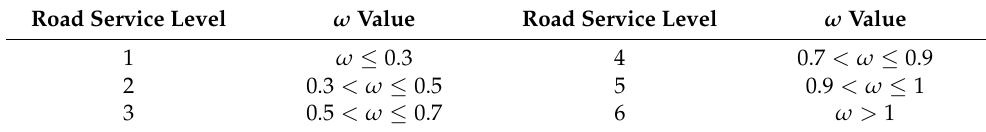
Table 2. The road service level